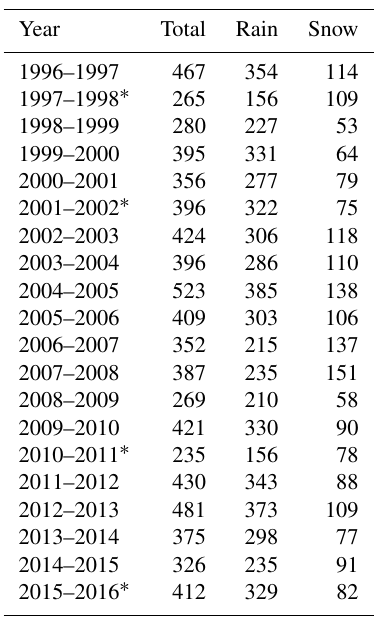
Table 2. Total hydrological year rainfall and snowfall from 1996 to 2016, interpolated for the Poplar Fen area.